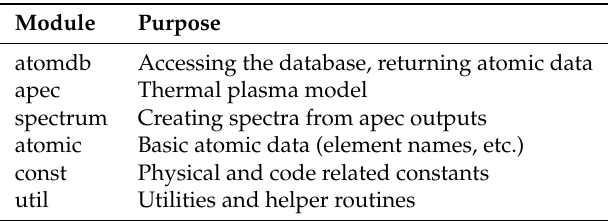
Table 3. Modules within PyAtomDB and their purpose. A full description is provided in the code documentation